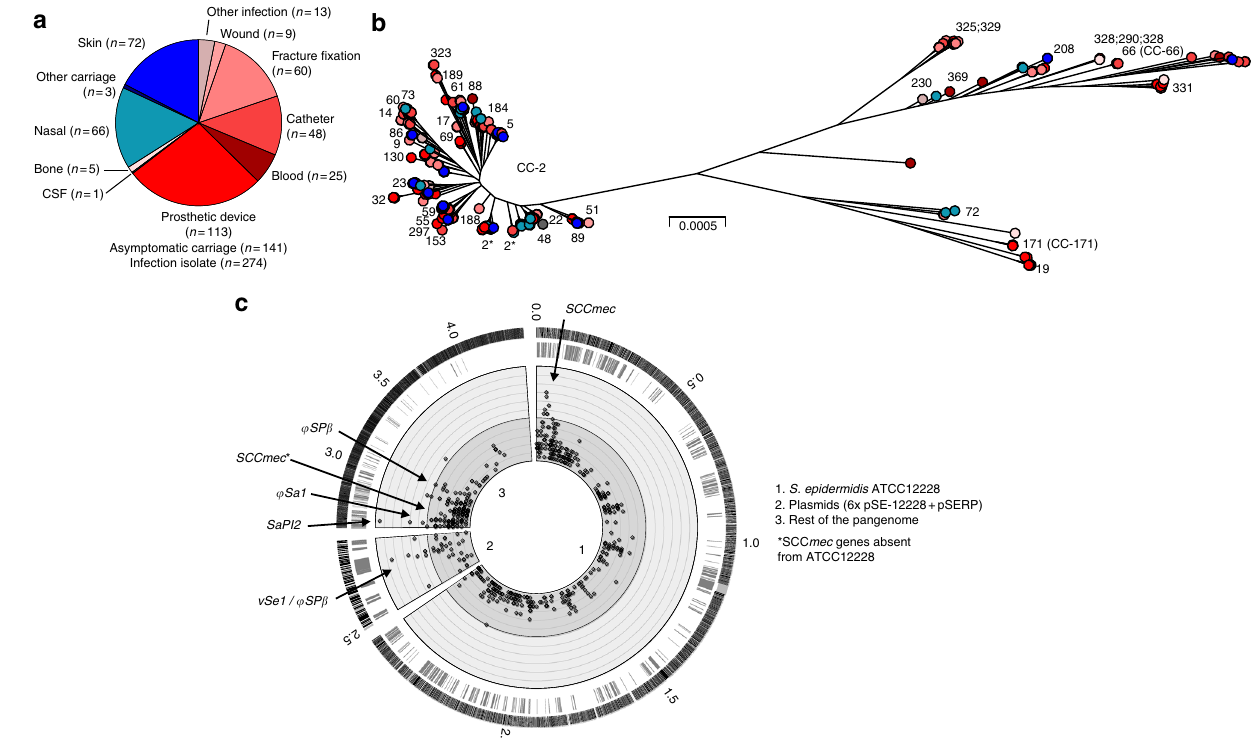
Fig. 2 Population structure and genome-wide association study of S. epidermidis pathogenicity. a Isolation source of 274 infection and 141 asymptomatic carriage isolates. Shades of red correspond to the broad infection phenotype, shades of blue to the broad asymptomatic carriage phenotype. b Phylogenetic tree of 415 S. epidermidis isolates, reconstructed using an approximation of the maximum-likelihood algorithm (FastTree2) from a core genome alignment ( n = 1946 genes shared by all isolates). Colours correspond to those used in panel A. Numbers correspond to sequence-types (STs) according to the Miragaia MLST scheme (https://pubmlst.org/sepidermidis/). c Pangenomic position of GWAS results. Ticks in the outer ring represent the pangenomic position of genes in the S. epidermidis ATCC12228 reference genome, seven plasmid genomes, and the rest of the pangenome inferred in this study. Ticks in the second layer show the position of genes containing associated k-mers in the GWAS. Grey circles are shown for the most statistically associated (lowest p-value) k-mer mapping to that gene. The threshold for signi fi cance (Fisher exact test) was P -value = 0.0001 (inner circle). Concentric rings emanating from this threshold correspond to incremental reductions in P -values from 1 × 10 -4 to 5 × 10 -7 (dark grey rings) and values < 5 × 10 -7 (light grey rings). The position of genes in well-known pathogenicity islands (SCCmec, φ SP β , φ Sa1, SaPI2, vSe1/ φ SP β ) is